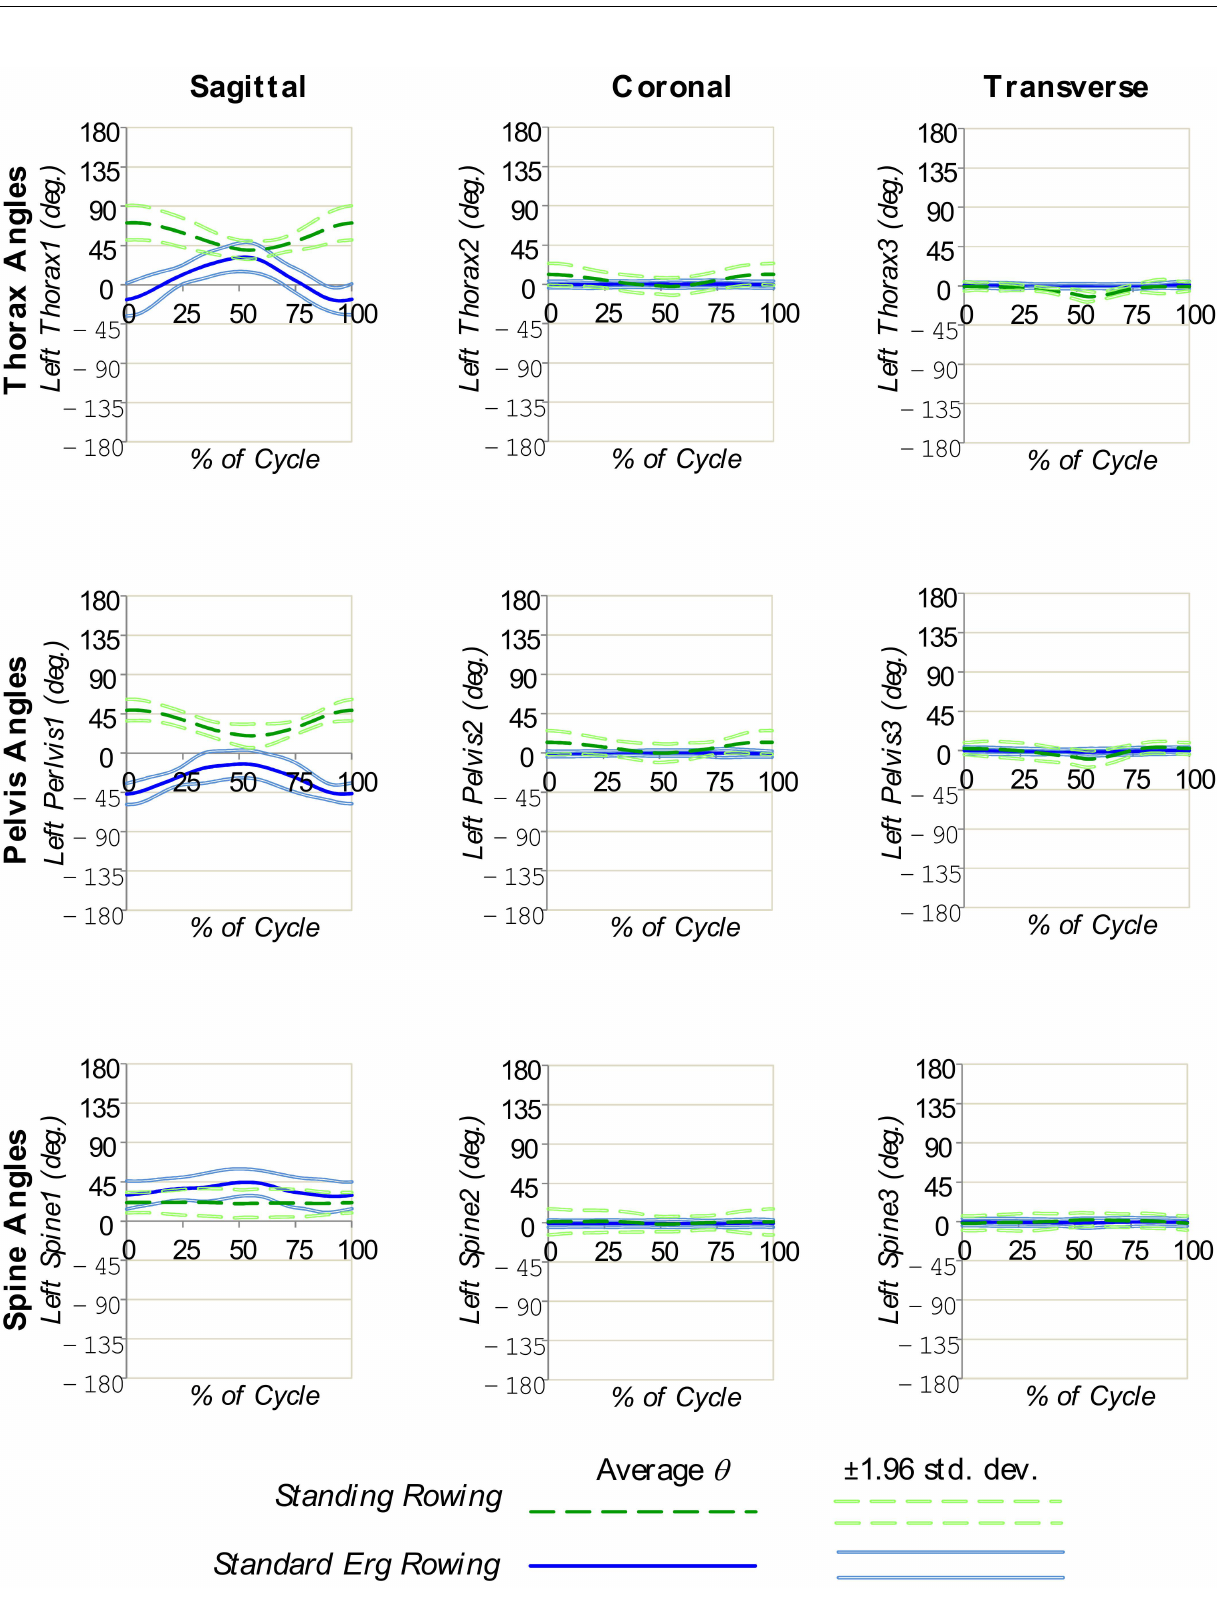
Figure 5. The averaged angular measurements for the thorax, pelvis and spine from the laboratory study, reported as mean ± 1.96 s.d., which compares standing rowing (green) with standard ergometer sliding-seat rowing